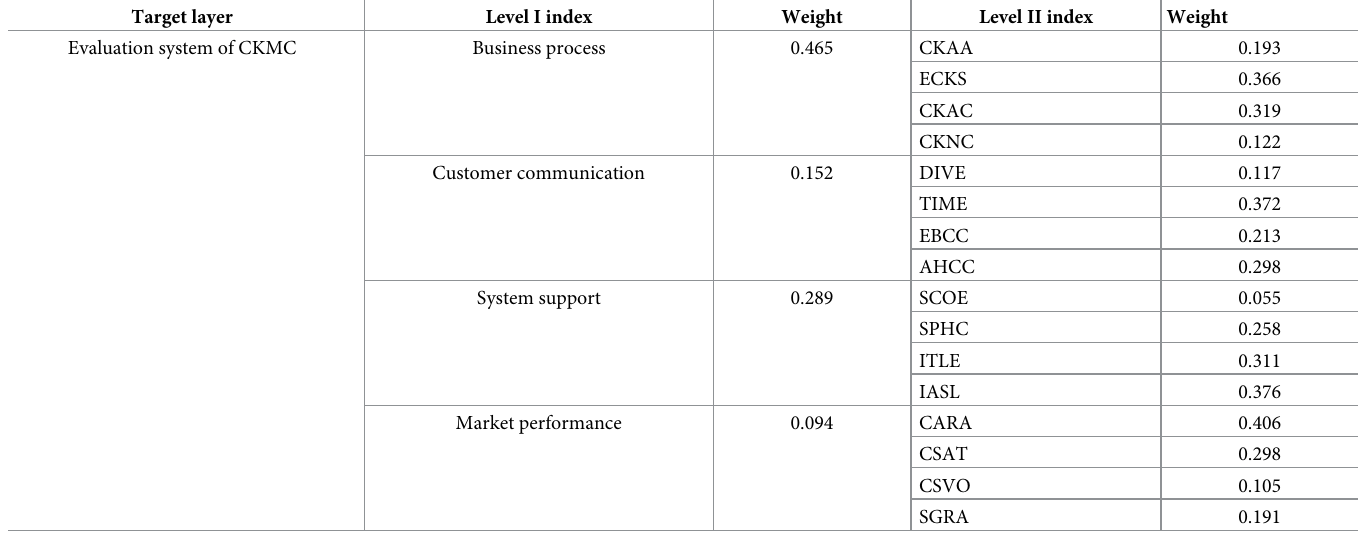
Table 5. Weights of index